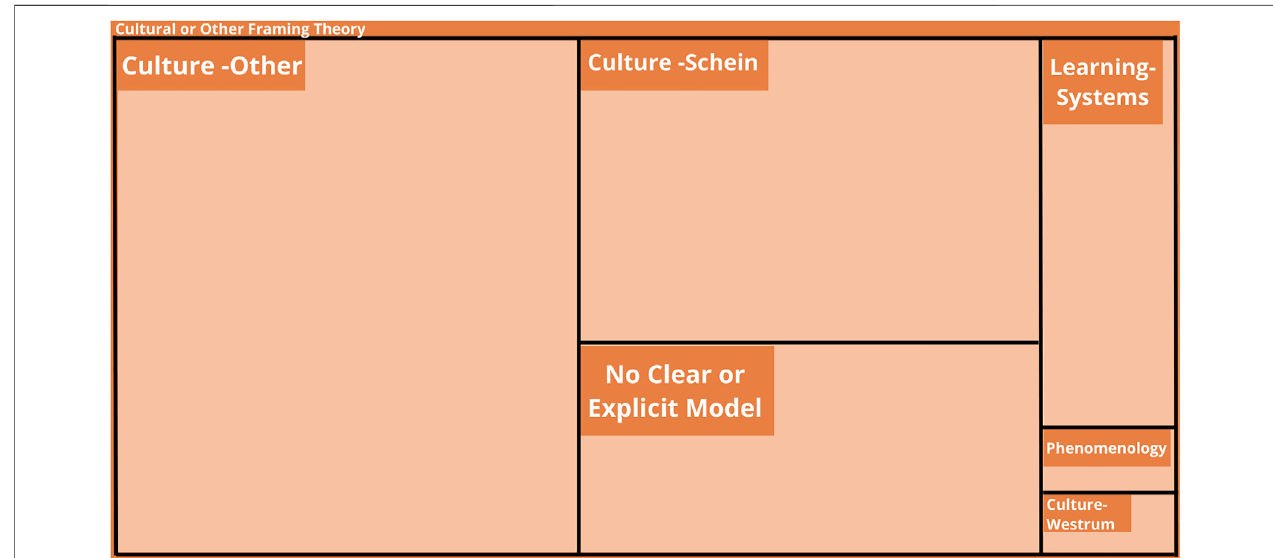
FIGURE 2 | Culture and other theory node tree